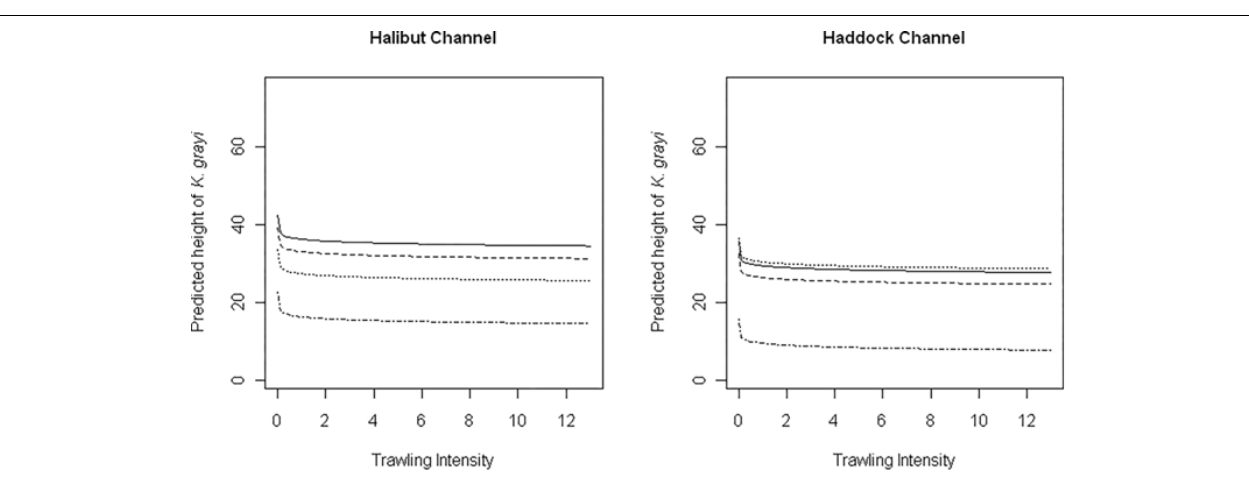
Frontiers in Marine Science |